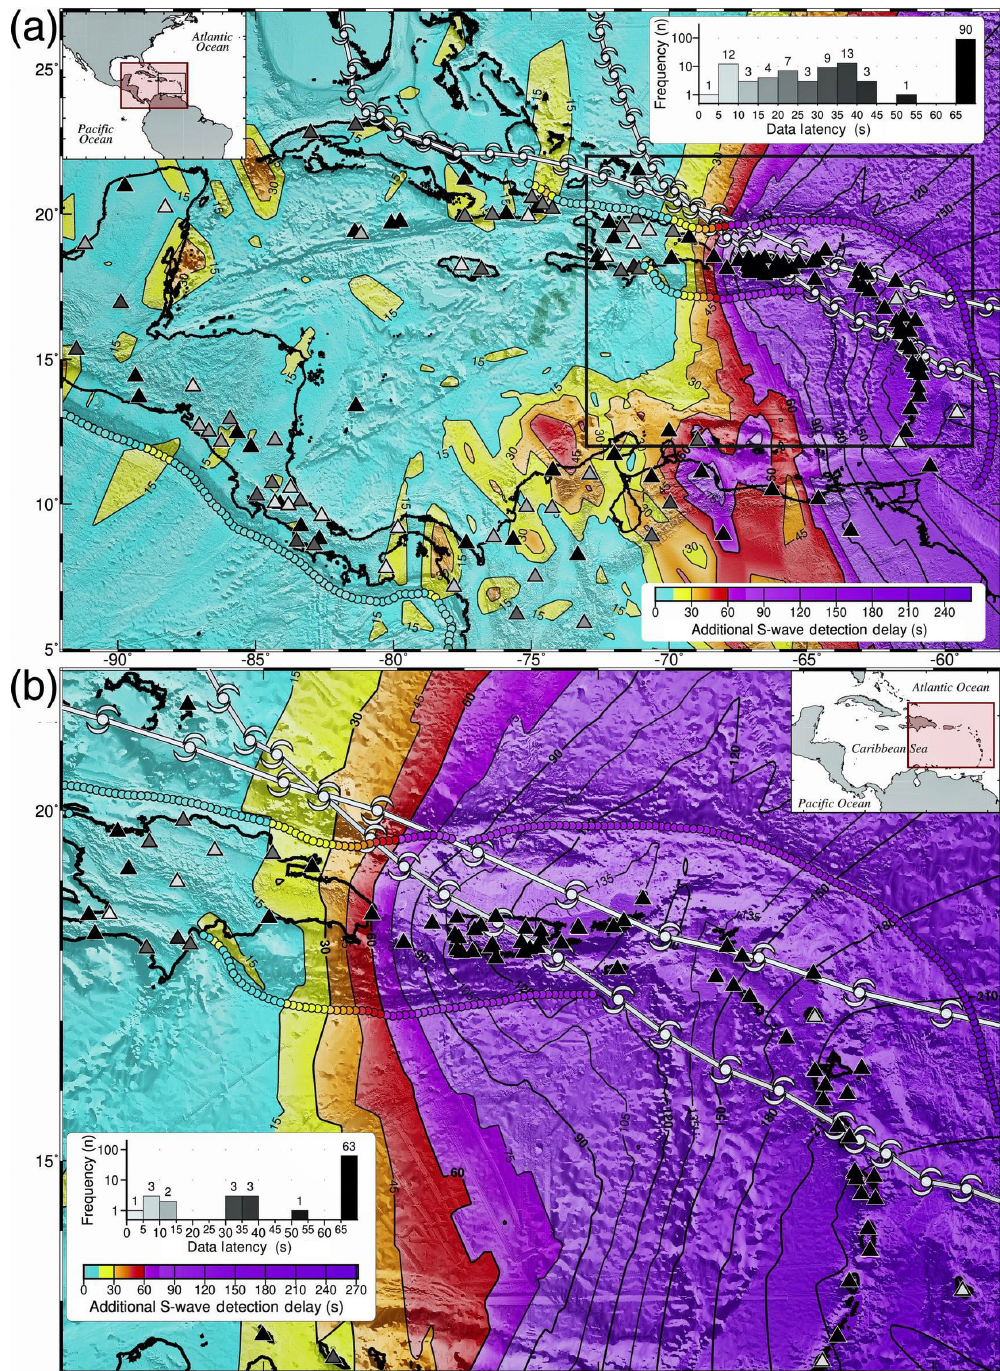
Figure 8. Impact of hurricanes Irma and Maria on the detection time of the first arriving S wave at a minimum of five stations in the Caribbean after (a) subtracting the median S wave detection times shown in Fig. 2b from those in Fig. 6b and (b) zooming into the rectangular area monitored by the PTWC local processing system for the Caribbean. The hurricanes caused additional S wave detection delays of more than 15s across 45% of the Caribbean region. Within the eastern Caribbean shown in (b) , however, additional S wave detection delays of more than 15s affect 78% of the area, with delays of 60–273s (00:15–04:33) affecting 61% of the area. The small, contiguous circles show the computed S wave detection delays sampled every (a) 25km and (b) 10km along the trench axes. White vortex tracks show the paths of hurricanes Irma to the north and Maria to the